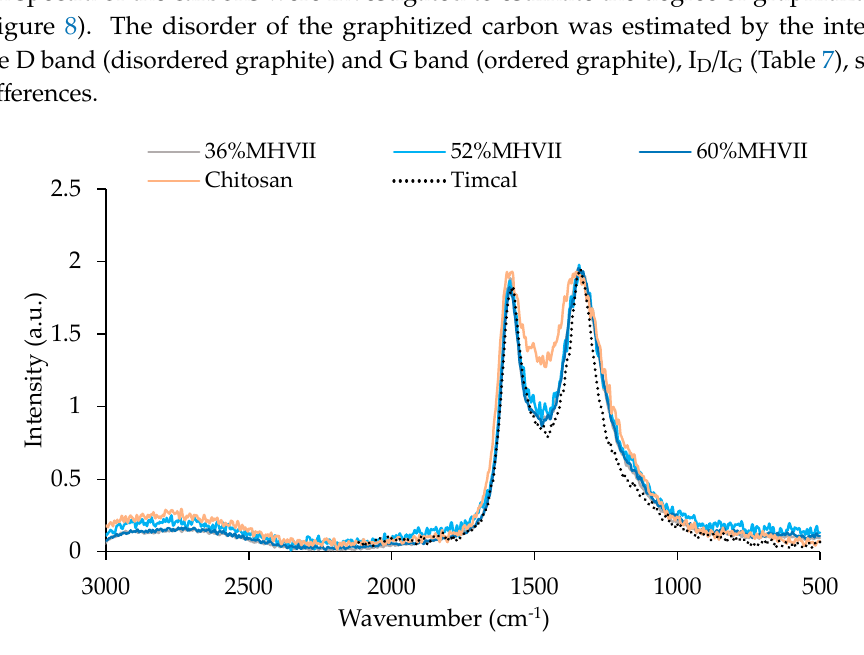
Figure 8. Raman spectra of all carbons prepared for the Li-O 2 battery cell studies.